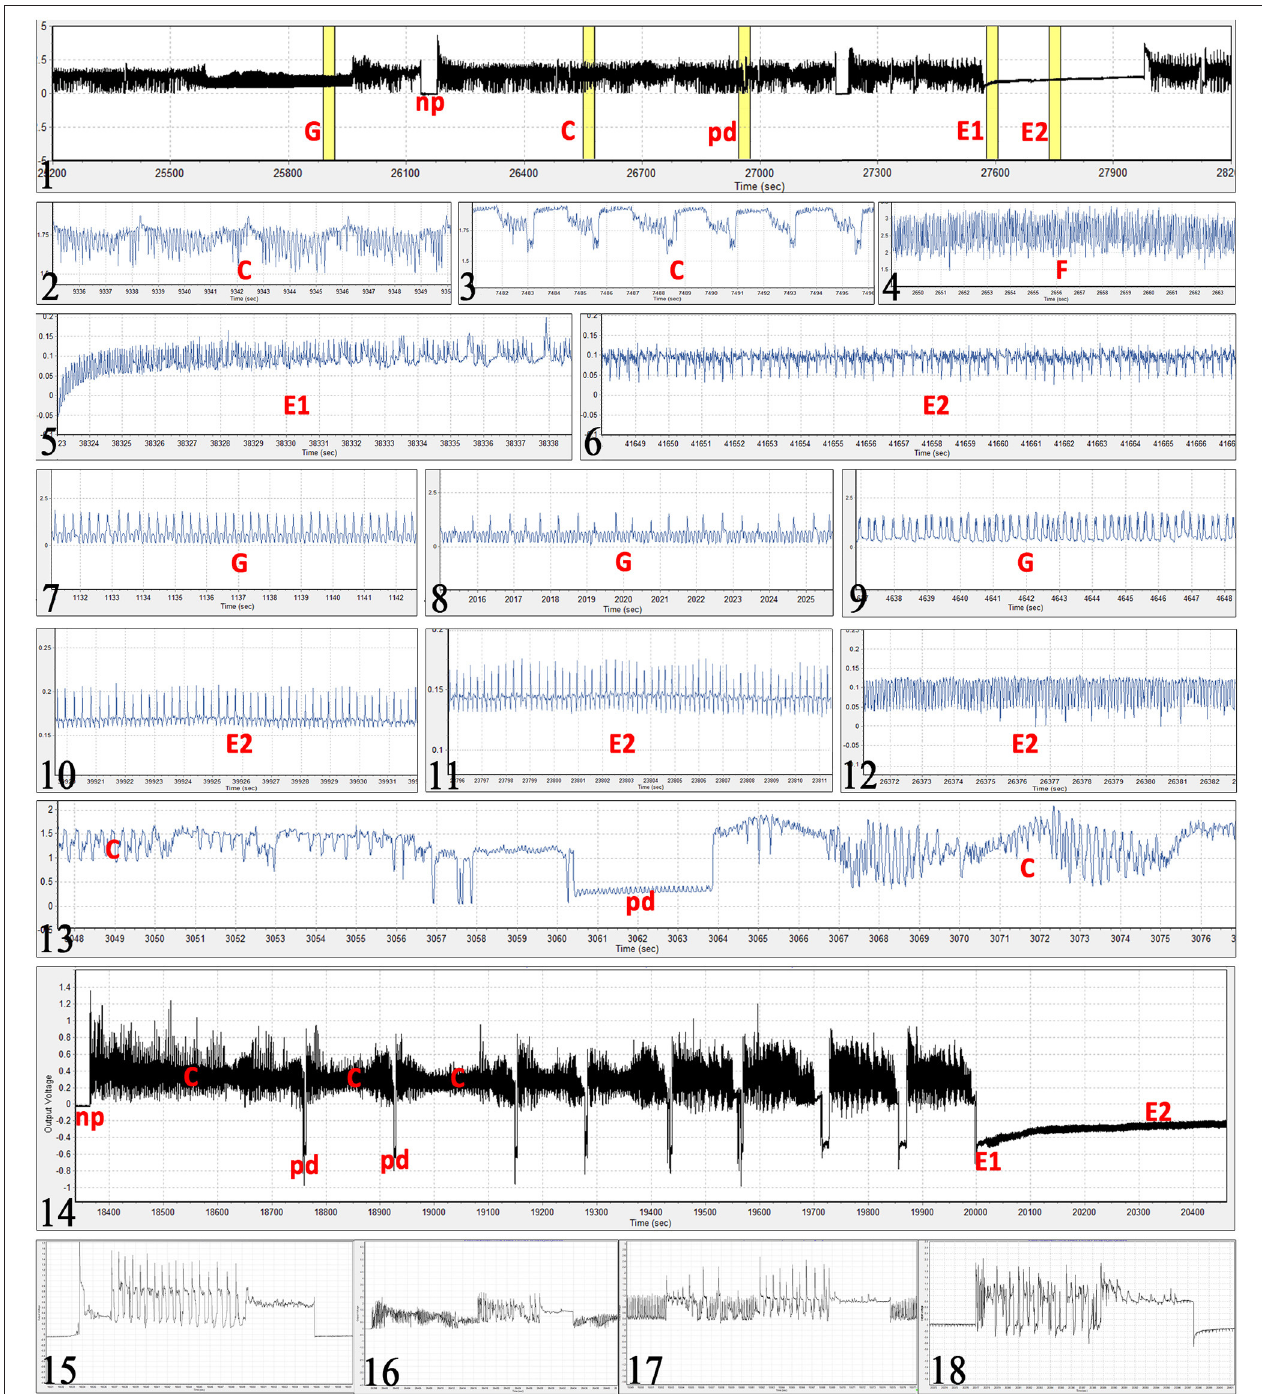
FIGURE 2 | Bemisia tabaci EPG waveforms observed in the study. ( Figure 1 ) Example of 1h EPG with xylem feeding (G), non-probing (np), stylet pathway (C), potential drop (pd), phloem salivation (E1), and phloem ingestion (E2) waveforms. (2) stylet pathway and sheath salivation (C). (3) different form of the pathway waveform C. (4) derailed stylet mechanics (F), note the high frequency. (5) phloem salivation (E1) from its beginning, notice gradual increase in voltage level. (6) typical passive phloem ingestion (E2). (7–9) different forms of xylem feeding waveform (G), note that this waveform even though similar to those in Figures 5, 10, and 11, occurs at extracellular voltage levels (does not start with a potential drop). (10–12) different forms of phloem ingestion (E2). (13) intracellular puncture (pd) during pathway (C). (14) example of first 35min of a probe with 8 potential drops (pd) before reaching the sieve element of the phloem (E1 followed by E2). (15–18) oviposition waveform during non-probing (np), stylet pathway (C),) xylem feeding (G), and phloem ingestion (E2), respectively. Ticks on the time axis are 1s for all graphs except for: graph (1) 5min; (14) 100s; (16) 2s. Absolute voltage values on the y-axis are arbitrary in the EPG recordings.